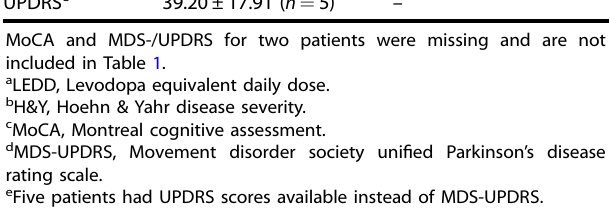
MoCA and MDS-/UPDRS for two patients were missing and are not included in Table 1. a LEDD, Levodopa equivalent daily dose. b H&Y, Hoehn & Yahr disease severity. c MoCA, Montreal cognitive assessment. d MDS-UPDRS, Movement disorder society uni fi ed Parkinson ’ s disease rating scale. e Five patients had UPDRS scores available instead of